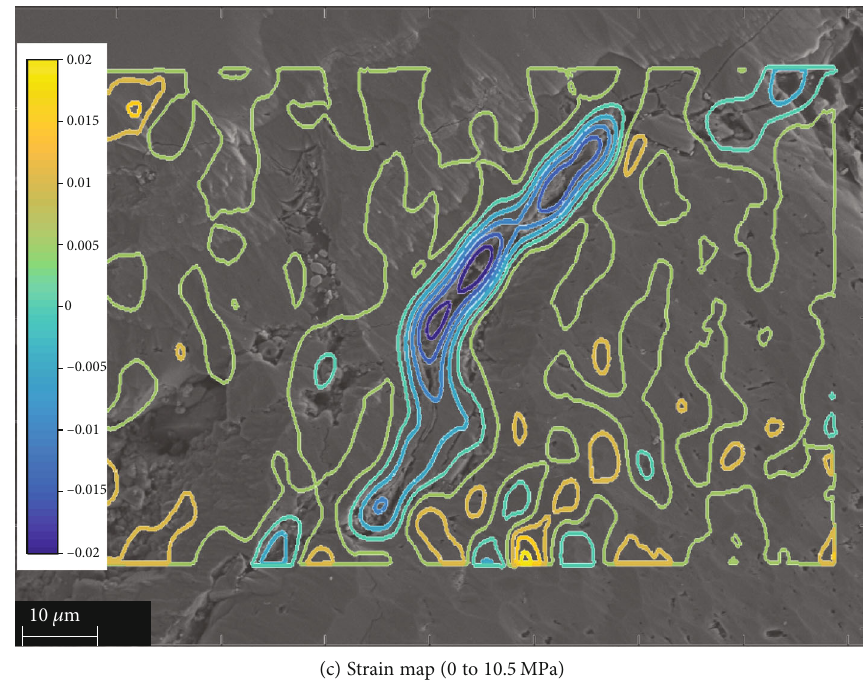
Figure 10: Strain fi eld map at di ff erent stress states.